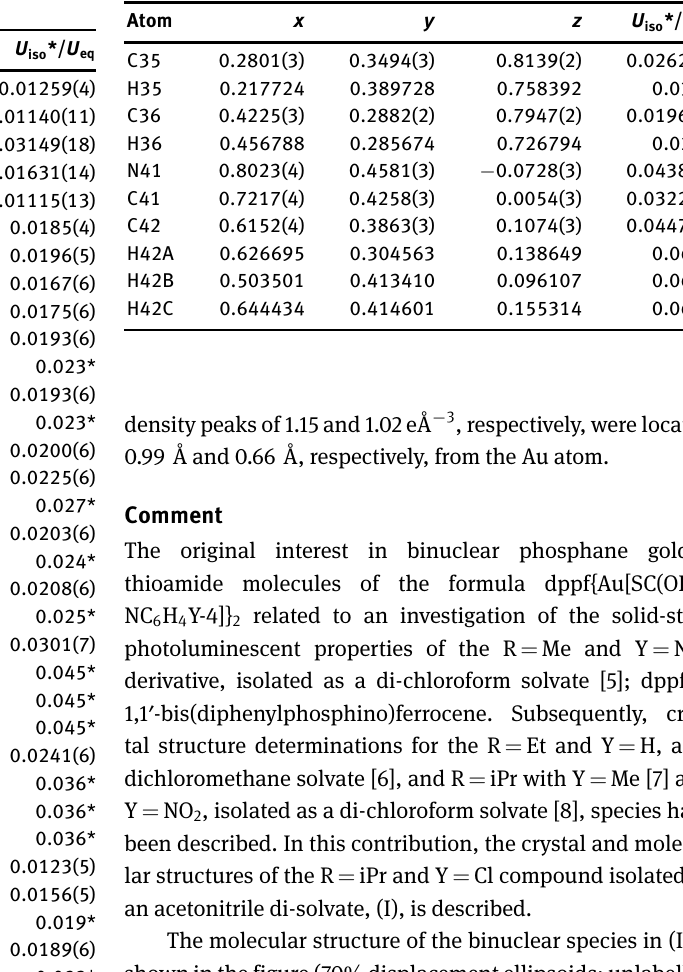
Table 2: Fractional atomic coordinates and isotropic or equivalent isotropic displacement parameters (Å 2